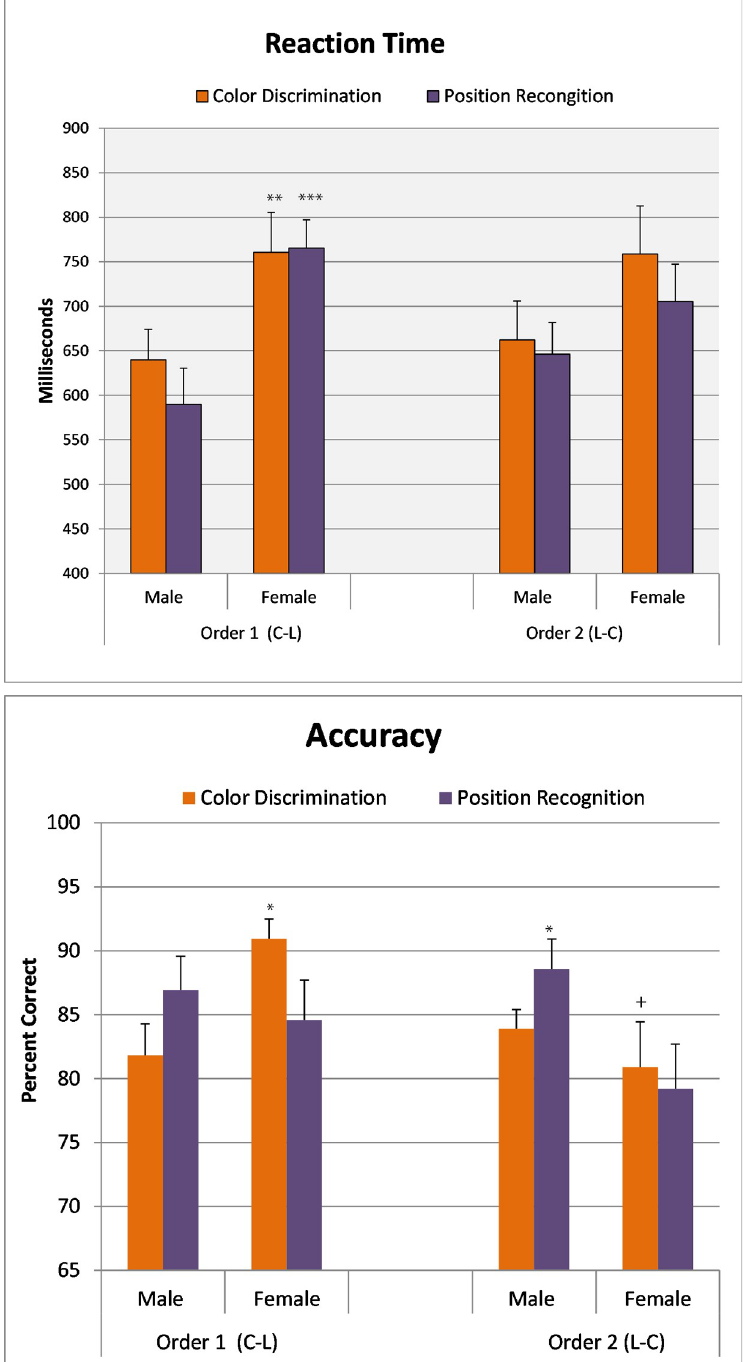
Fig 3. Reaction time and accuracy: Effect of intructional order for color and position matching. Data shown are the mean ( ± SEM). Order 1 tested for color first followed by testing for position. Order 2 tested for position first. Separate groups of males and females were tested in each order. Top Panel: Reaction time to make a correct matching decision (Yes/No). �� p < 0.01, ��� p < 0.001 compared to opposite sex in the same order. Bottom Panel: Percent of correct answers from same participants. � p < 0.05 compared to opposite sex in same order. + p < 0.05 from same sex in opposite order.